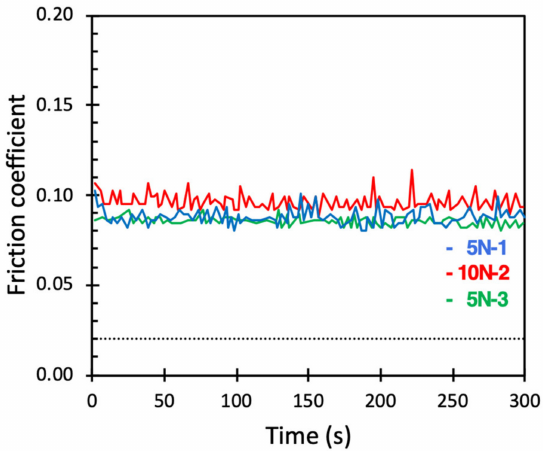
Figure 5. Friction coefficient between macroscopic borosilicate surfaces across PBS containing 0.5 mg/mL DPPC vesicle dispersions. Numbers 1, 2 and 3 displayed after the load (5 N or 10 N) report the order in which the load was applied. The dotted line corresponds to a friction coefficient of 0.02, similar to what was observed for DPPC bilayers at the nanoscale.